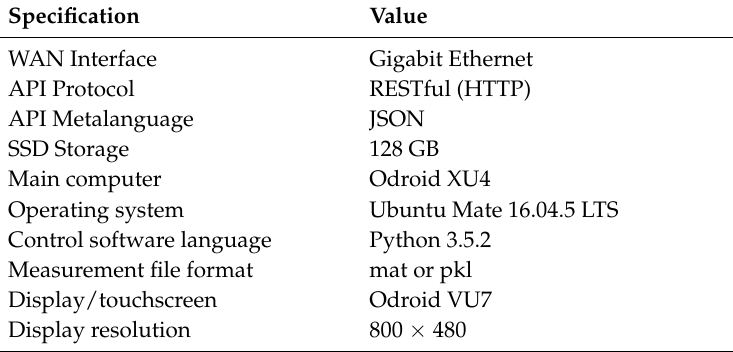
Table 5. Communications, interface and storage